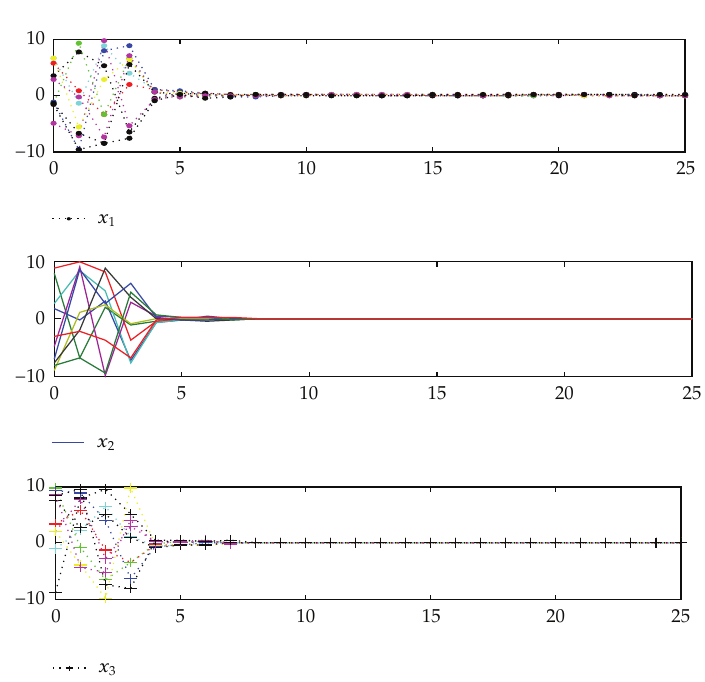
Figure 1: Global convergence of states x 1 , x 2 , and x 3 in Example 4.1, when d 1 (cid:7) 1 and d 2 (cid:7) 3.